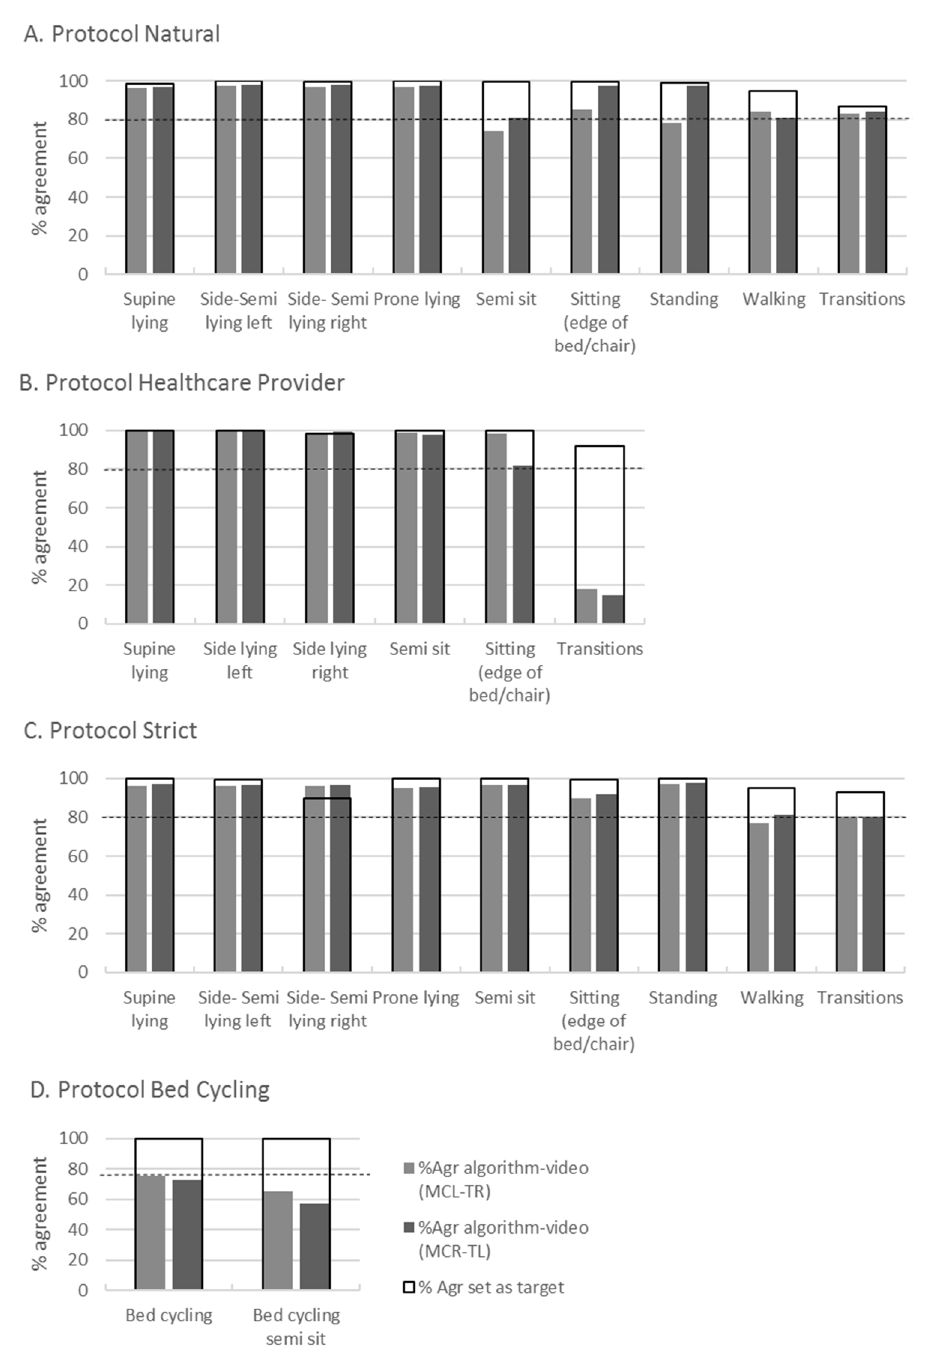
Figure 4. Validation of the developed algorithm showing percentage agreement of correct coded activity by the algorithm on the validation group ( n = 6) compared to target scores based on the percentage of agreement between both video raters for all four protocols. The dotted line shows the chosen validity value of 80%. Abbreviations: %Agr, percentage agreement; MCL, midclavicular line left, MCR, midclavicular line right, TL, thigh left, TR, thigh right.